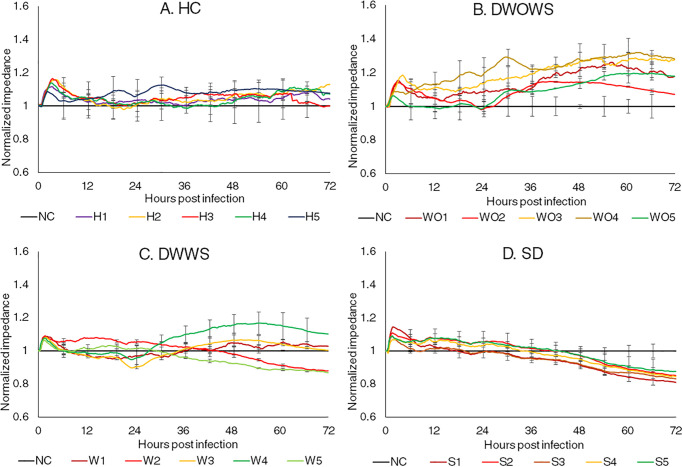
Normalized real time impedance changes in pulmonary MECs incubated with serum samples from the category of (A) Healthy individuals (HC), (B) dengue without warning signs (DWOWS), (C) dengue with warning signs (DWWS) and (D) severe dengue (SD). Five serum samples from each dengue category consisted of samples with high NS1 level (red lines), medium NS1 level (yellow lines) and low NS1 level (green lines). The error bars represented the standard error of mean between three biological triplicates for each sample.